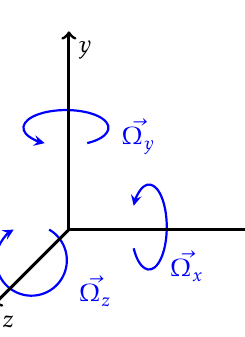
Figure 1. Domains of accelerometer (black) and gyroscope (blue)